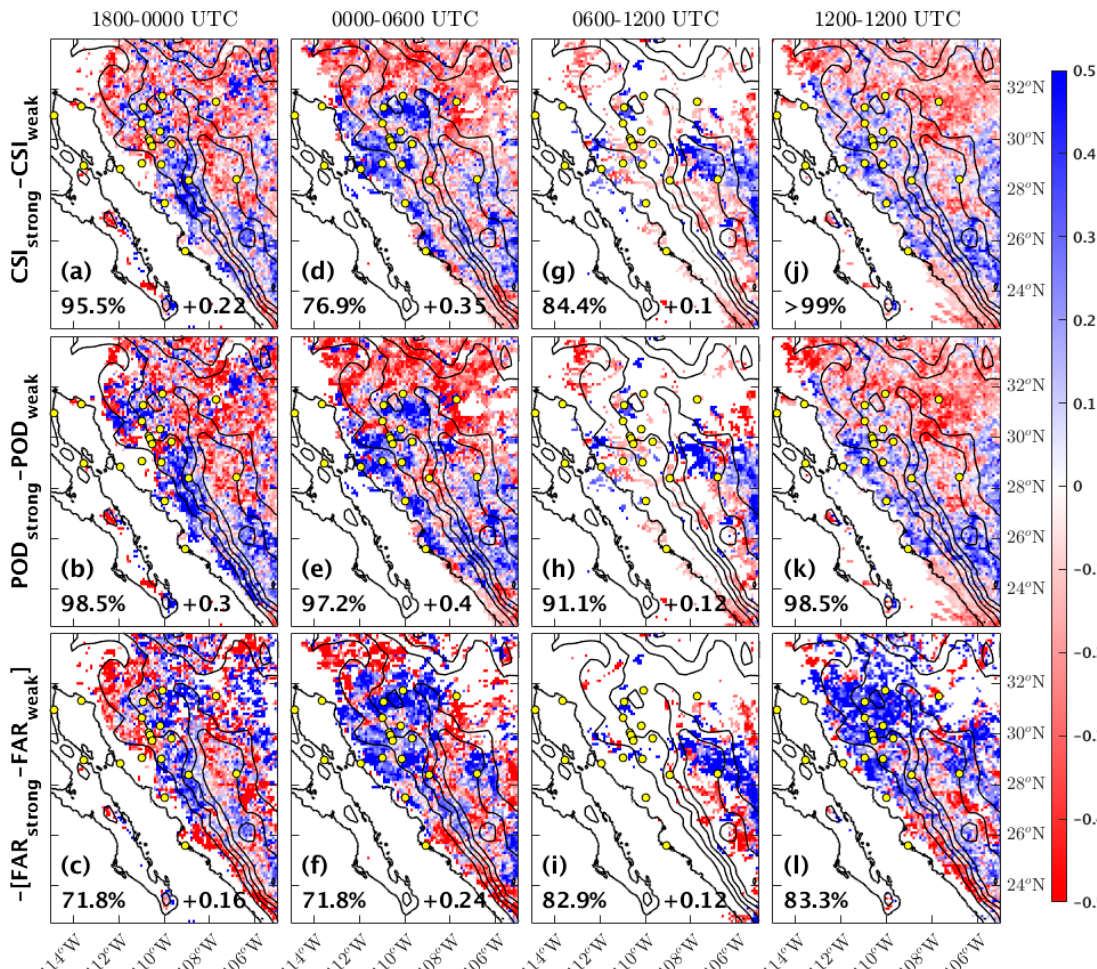
Field significance is displayed on the bottom left and the pattern correlation between the 6-hourly and the daily forecast metrics is on the bottom right of each panel.